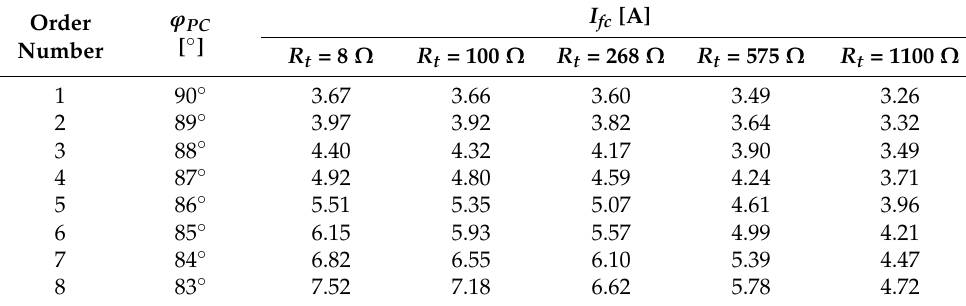
Table 9. Effective value of the fault current depending on ϕ PC , when ϕ c = 89 ◦ . Order